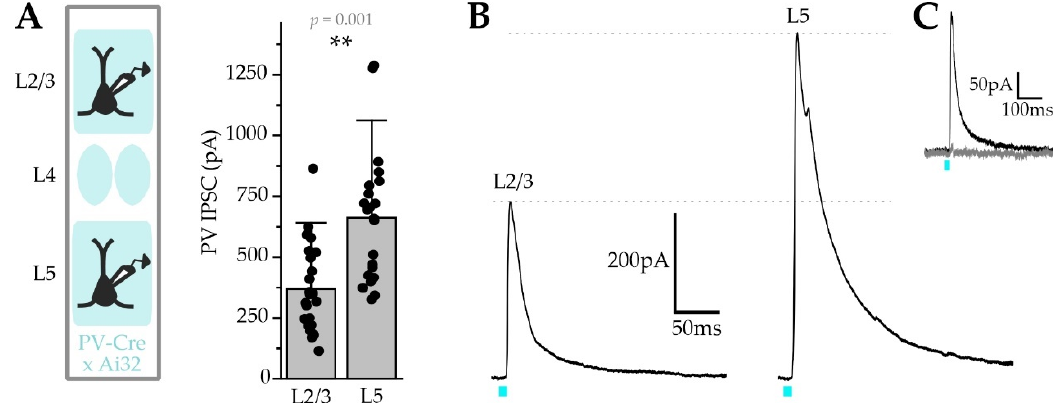
Figure 9. PV inhibition of L5 Pyr neurons is stronger than L2/3 Pyr neuron inhibition. ( A ) Left, schematic of recording. Right, PV-IPSC peak amplitude for L2/3 and L5 Pyr cells, ** p ≤ 0.01; ( B ) Example trace of a PV-IPSC from a single L2/3 ( left ) and L5 ( right ) Pyr neuron following blue-light stimulation (5 ms, blue tick mark); ( C ) A PV-IPSC recorded before (black) and after bath application of picrotoxin (grey); L2/3, n =24 cells; L5, n = 22 cells; N = 4 animals.